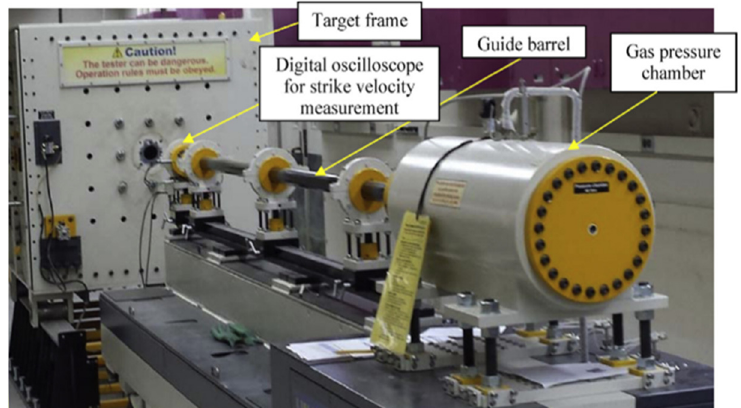
Figure 8. The gas gun used for projectile impact tests. Buildings 2022 , 12 , 1815